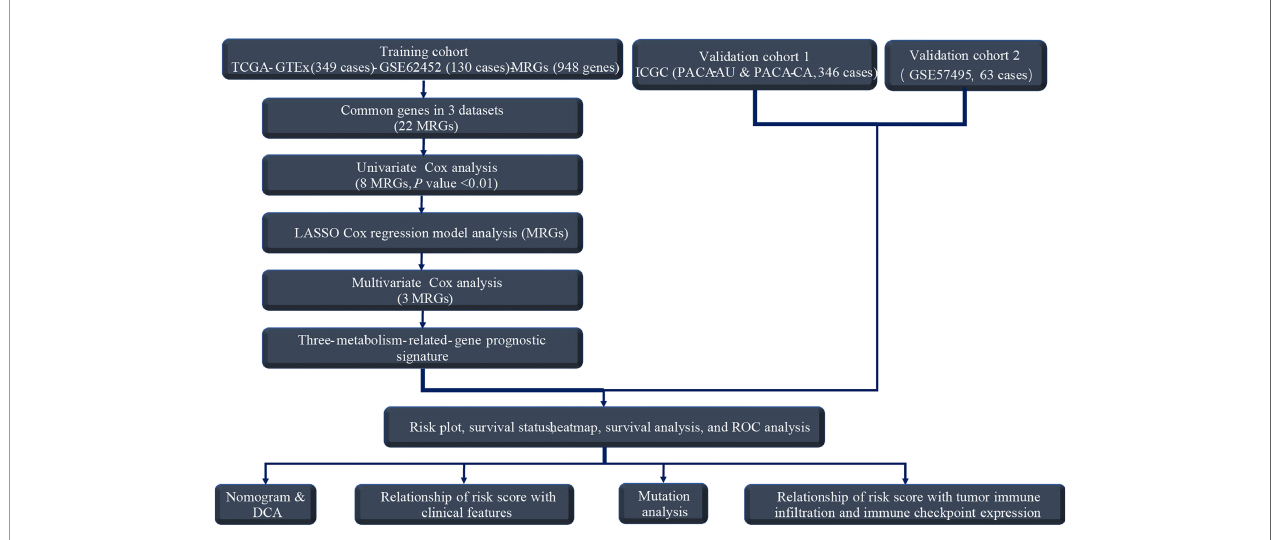
FIGURE 1 | The fl owchart for analyzing MRGs-prognostic